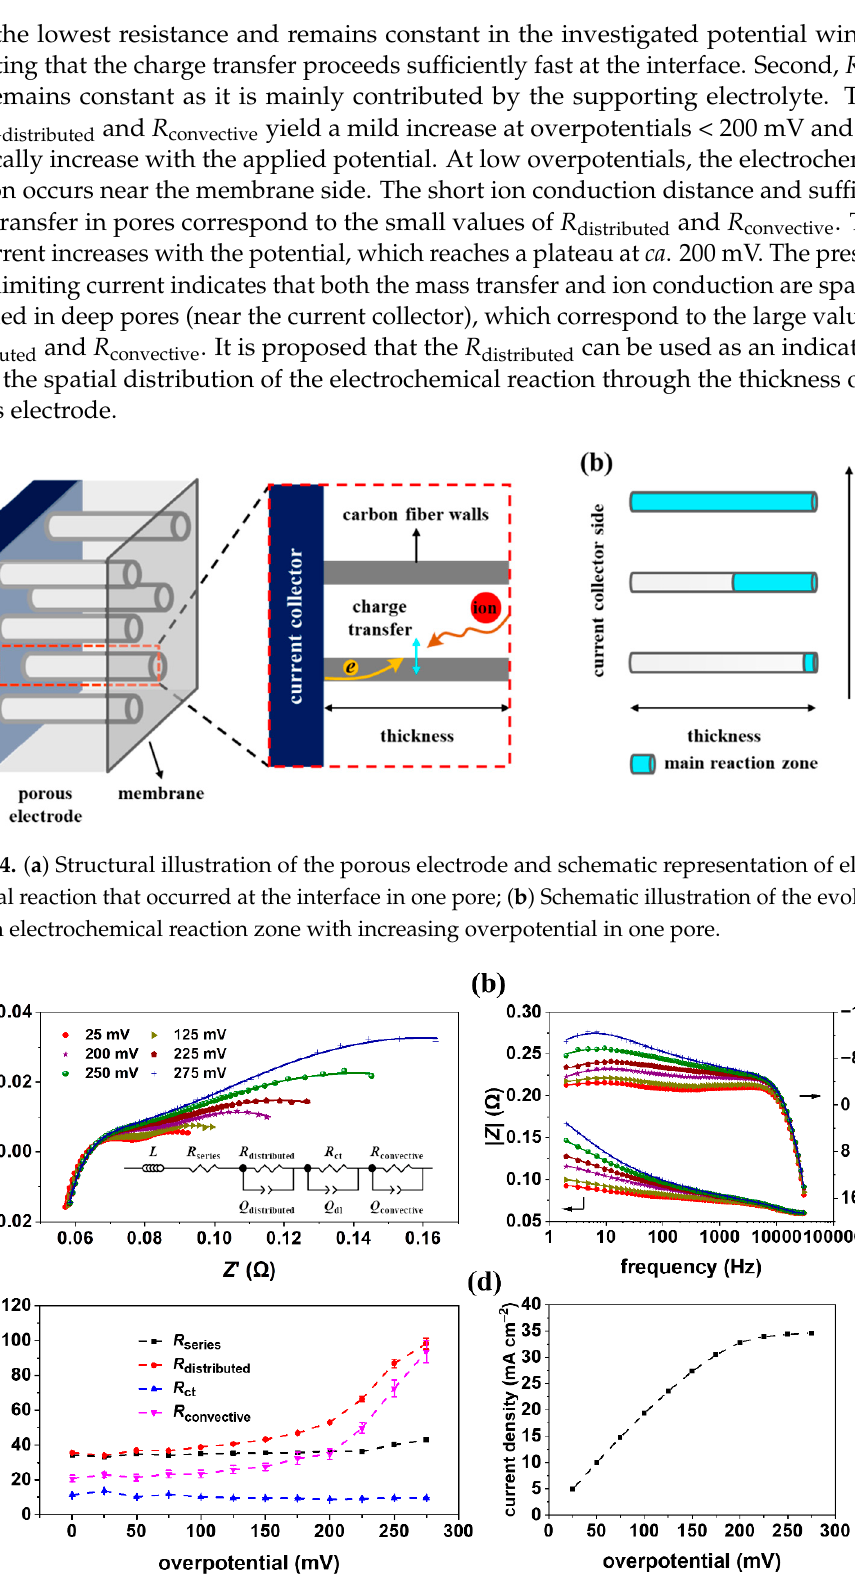
Figure 5. Effect of anodic polarization on the impedance and the current density. ( a ) Nyquist plots; ( b ) Bode plots; ( c ) Resistance value derived from the data fitting; ( d ) Polarization curve. The cell was assembled using 5 mm-thick electrodes. The electrolyte concentration was 0.050 M K 3 [Fe(CN) 6 ] at 50% SOC. The measurements were performed at a flow rate of 20 mL min − 1